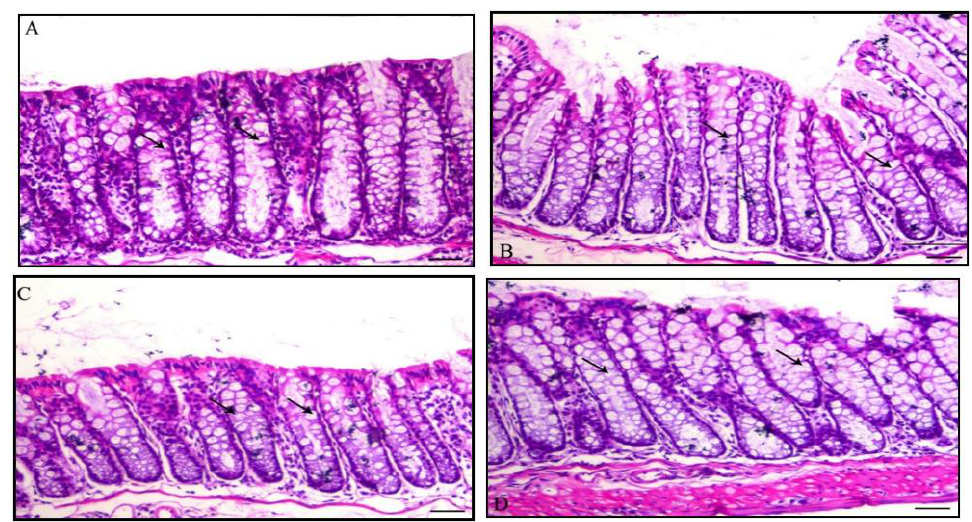
Figure 5. Quantitative assessment of dysplastic foci within different groups. a represents statically significant differences at ( p < 0.05), compared different groups with Group-I and b represents stati- cally significant differences at ( p < 0.05), compared different groups with Group-IV.